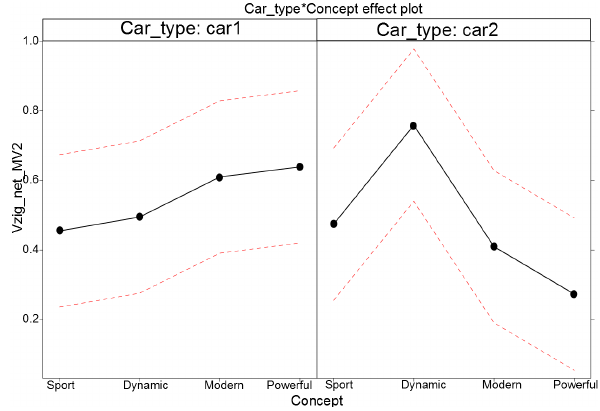
Figure 6. Results of EMG and GSR measures